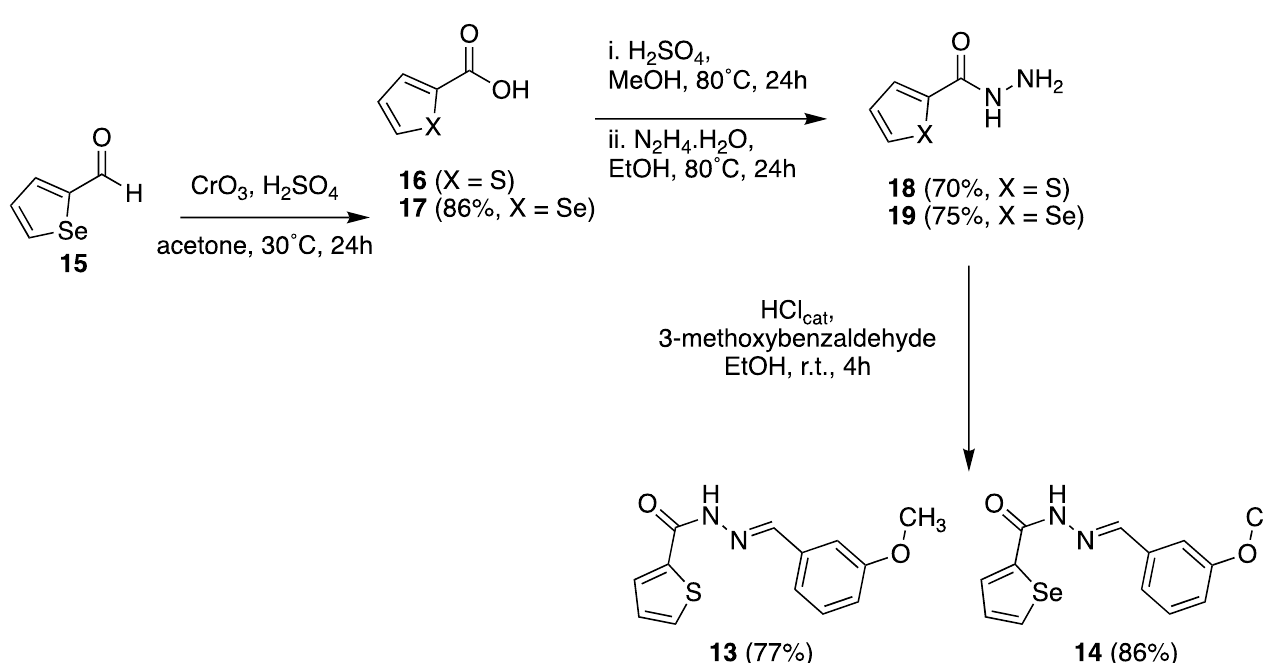
Scheme 3. Synthetic scheme for the preparation of retroisosteric derivatives 13 and 14 . Reaction conditions and yields for the synthesis of thiophenic and seleonphenic hydrazides and subsequent condensation to obtain retroisosteric NAH 13 and 14